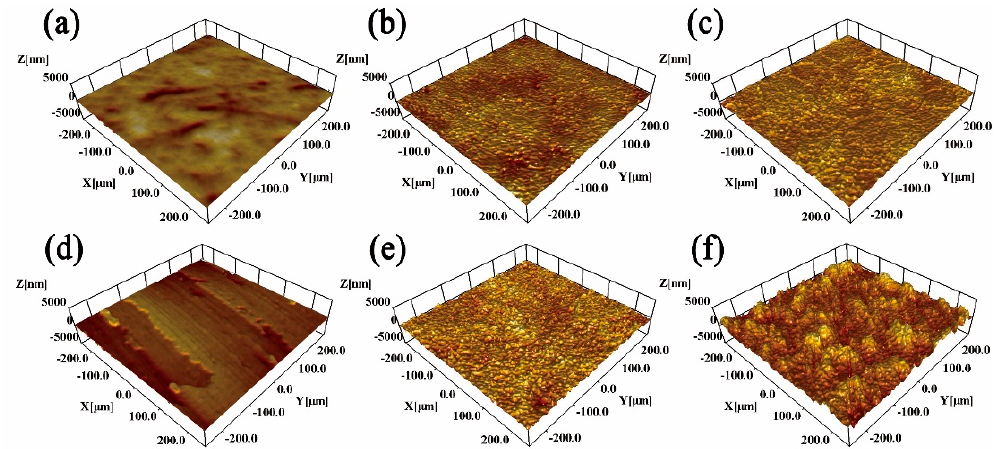
Figure 3. Typical SEM images showing surface morphologies of the ( a and c ) untreated and ( b and d ) USRP Ti plasma-nitrided at ( a and b )750 °C and ( b and d ) 850 °C.